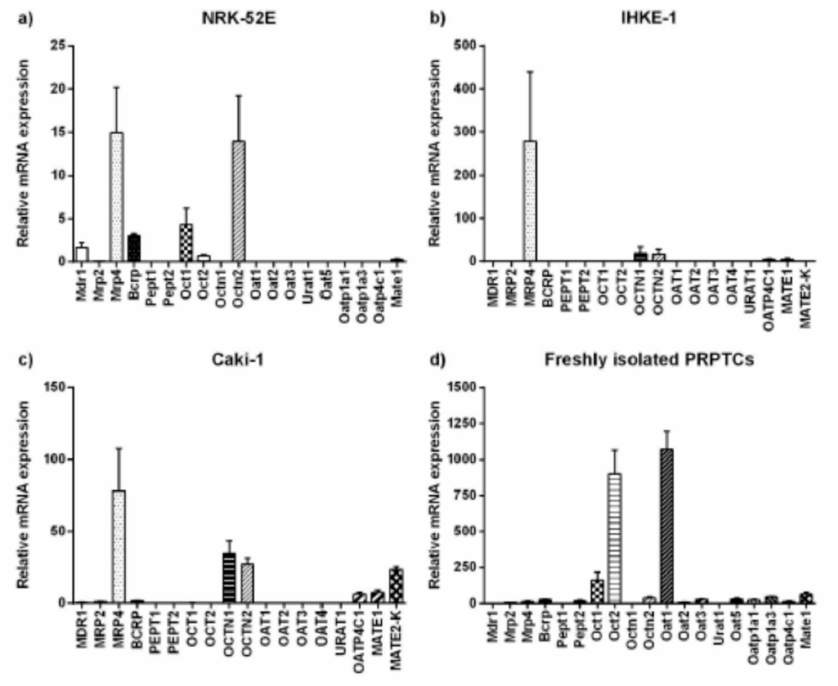
Figure 9. Relative mRNA expression of transport proteins in the renal cell lines NRK-52E ( a ), IHKE-1 ( b ) and Caki-1 ( c ), and in freshly isolated PRPTCs ( d ). The mRNA expression of each gene was normalized to GAPDH/Gapdh expression. Each bar represents the mean ± SD ( n =